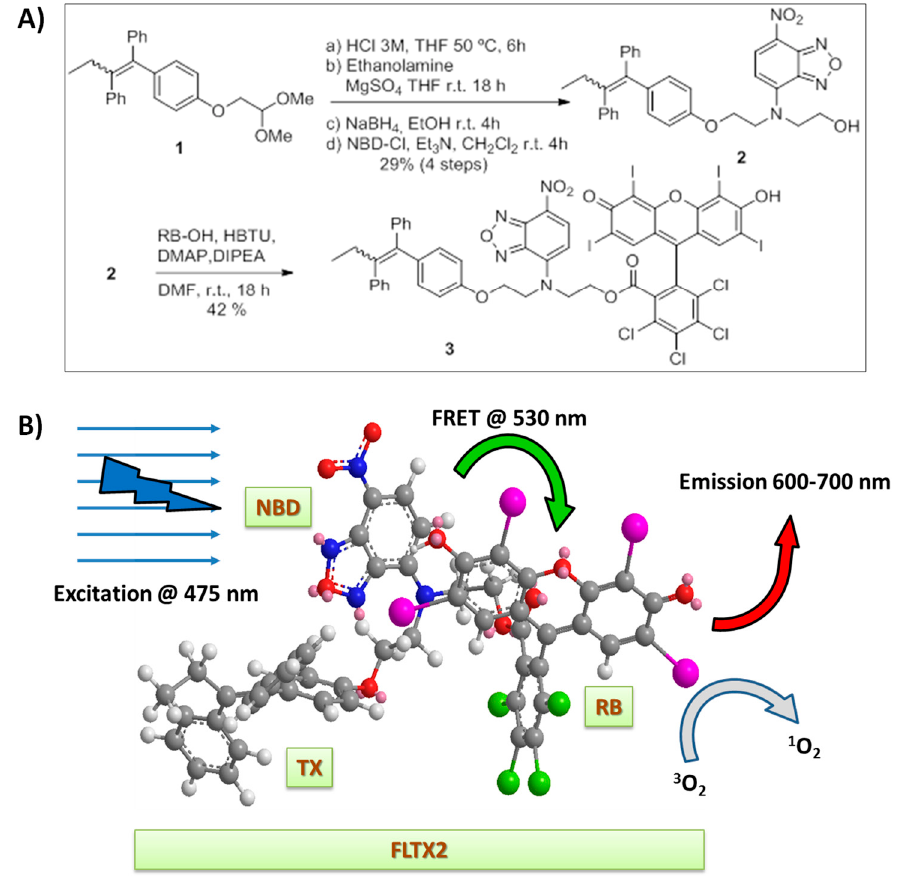
Figure 1. ( A ) Synthesis of FLTX2 (compound 3). ( B ) Minimized 3D representation of FLTX2 (3) highlighting the sequence: excitation wavelength, intramolecular FRET, red emission, and singlet oxygen generation. For details see optical measurements DIPEA: Diisopropylethylamine; DMAP: Dimethylaminopyridine; DMF: Dimethylformamide; HBTU: O-(Benzotriazol-1-yl)- N,N,N ′ ,N ′ -tetramethyluronium hexafluorophosphate; NBD: 7-nitrobenzofurazan; THF: tetrahydrofuran .